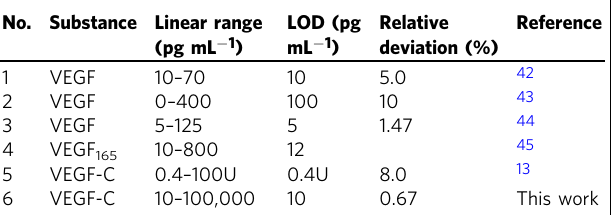
Table 2 Comparison results of the proposed VEGF-C immunosensor and other sensors for detection of VEGF.